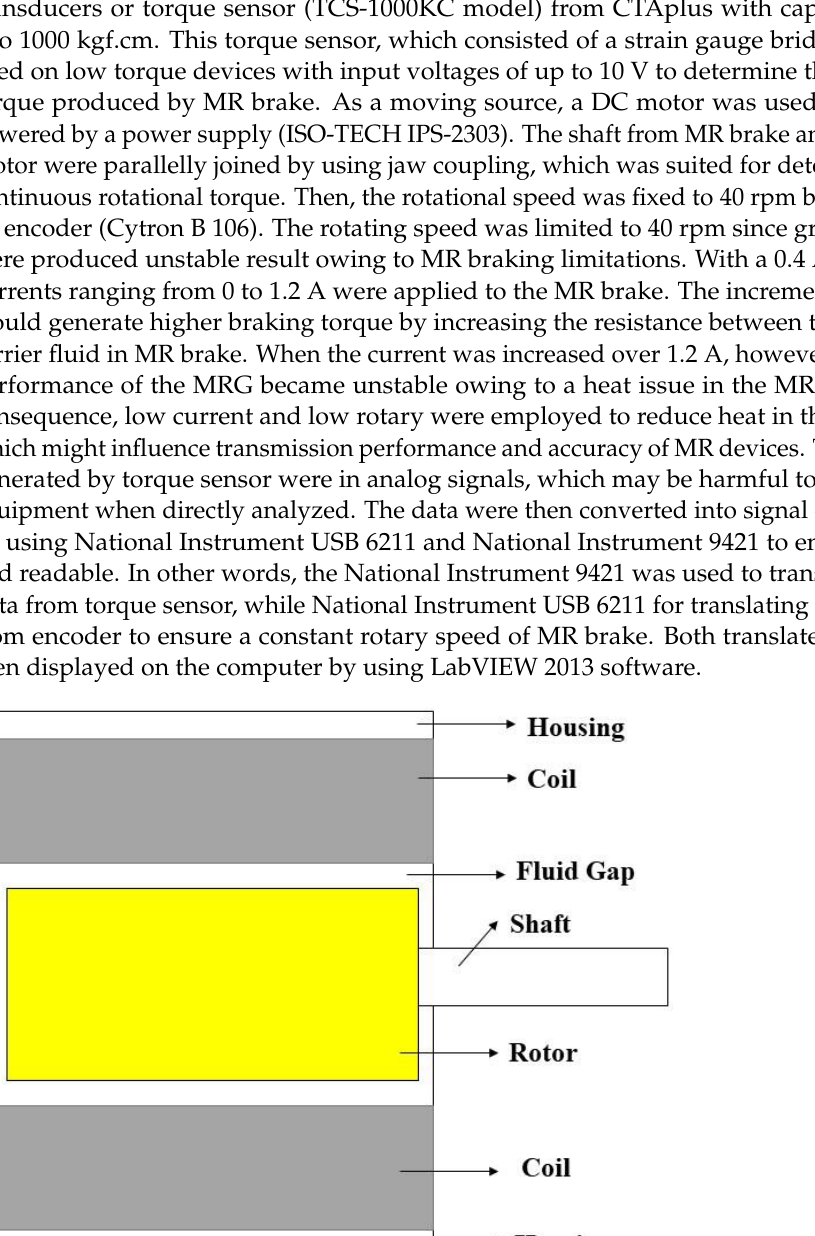
Table 2. Magnetic flux density of MRG.